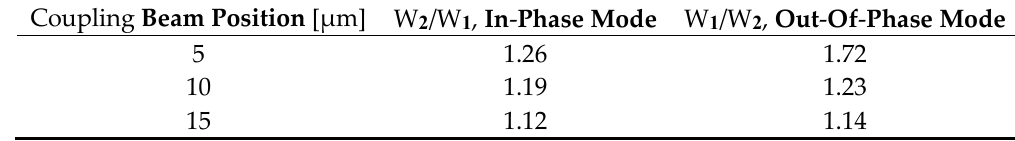
Table 1. Amplitude ratio of the shortest cantilever (W 1 ) and the longest cantilever (W 2